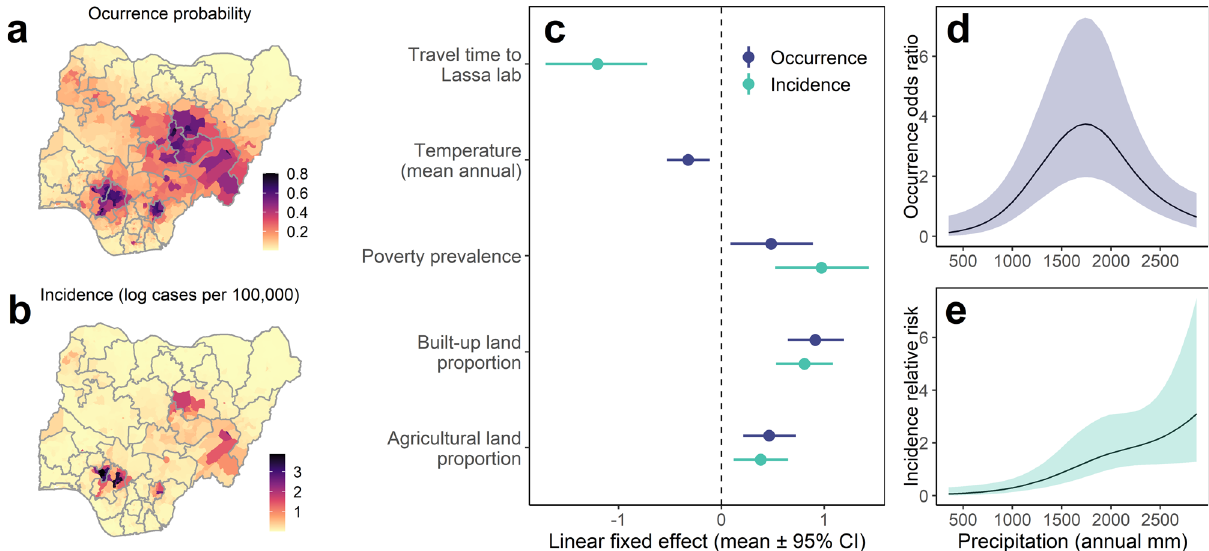
Fig. 3 Spatial distribution and correlates of annual Lassa fever occurrence and incidence (2016 to 2019) at local government authority level across Nigeria. Maps show fi tted probability of LF occurrence ( a ) and incidence ( b ; cases per 100,000 persons, visualised on the natural log scale) for 774 LGAs in 2019. Points and error-bars ( c ) show socio-ecological linear fi xed-effects parameter estimates (posterior mean and 95% credible interval) for best- fi tting models of Lassa fever occurrence (dark blue; log odds scale) and incidence (pale green, log scale) ( n = 3096 observations). Linear covariates were centred and scaled before fi tting, so parameters measure the effect of 1 scaled unit change in the covariate (1 standard deviation) on either log odds of occurrence or log incidence. Curves show nonlinear effects of total annual precipitation on LF occurrence (odds ratio; d ) and incidence (relative risk; e ), speci fi ed and fi tted as second-order random walks. Models included spatiotemporally structured random effects (LGA per year) to account for geographical heterogeneity and expansion of reporting effort (Methods) and were robust to cross-validation tests (Supplementary Fig. 3) and modelling at lower spatial resolution (Supplementary Fig.